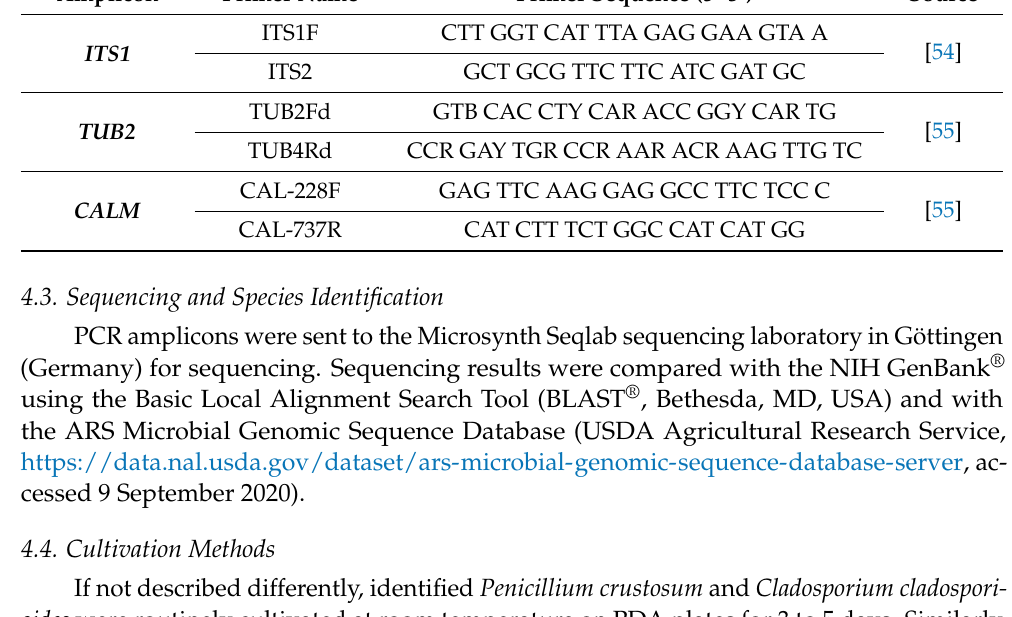
Table 2. Primers used for amplification and sequencing of marker genes to determine fungal species.